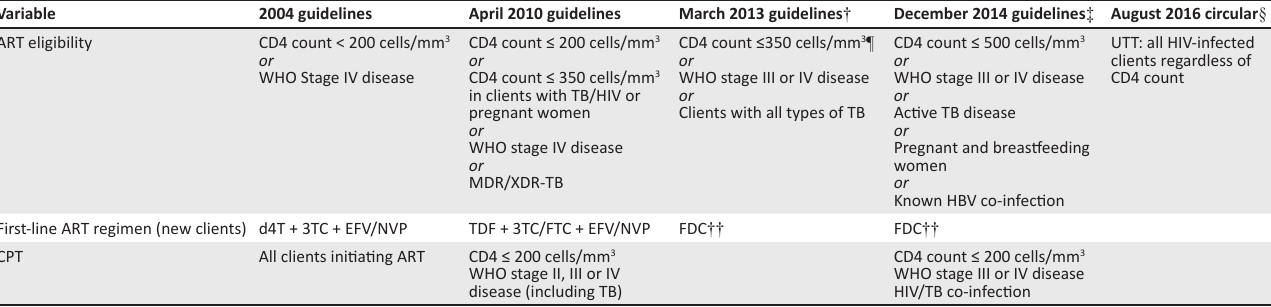
TABLE 1: South African guidelines for treatment of adults with human immunodeficiency virus infection.